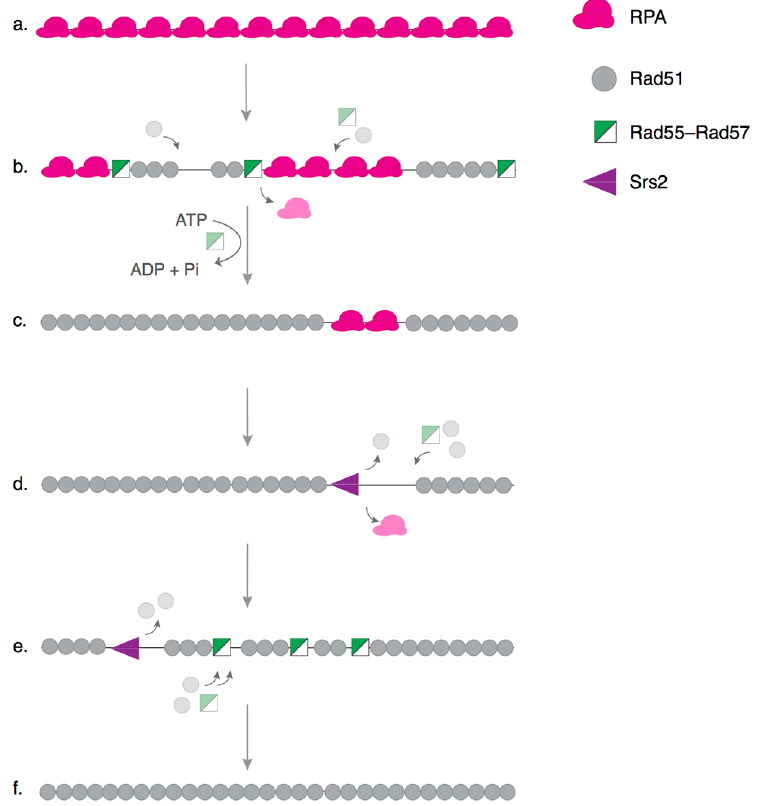
Figure 2. Model for the role of Rad55–Rad57 in presynaptic complex assembly. ( a – c ) Rad55–Rad57 stimulates Rad51 filament assembly onto RPA-coated single-stranded DNA (ssDNA) through tran- sient binding interactions, and rapidly dissociates when Rad55 hydrolyzes ATP. ( d ) The antirecom- binase Srs2 can disrupt Rad51 filaments as it translocates along ssDNA. ( e , f ) The Rad51–ssDNA filament is restored by the continuous stimulatory action of Rad55–Rad57, which acts as a molecular chaperone and leads to more extensive Rad51–ssDNA filament